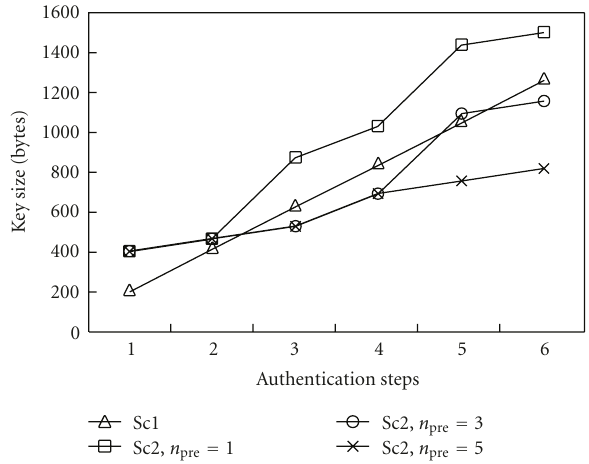
Figure 11: Number of keys generated by HSS and HAAA. Figure 12: Memory storage space required by the UE to store security